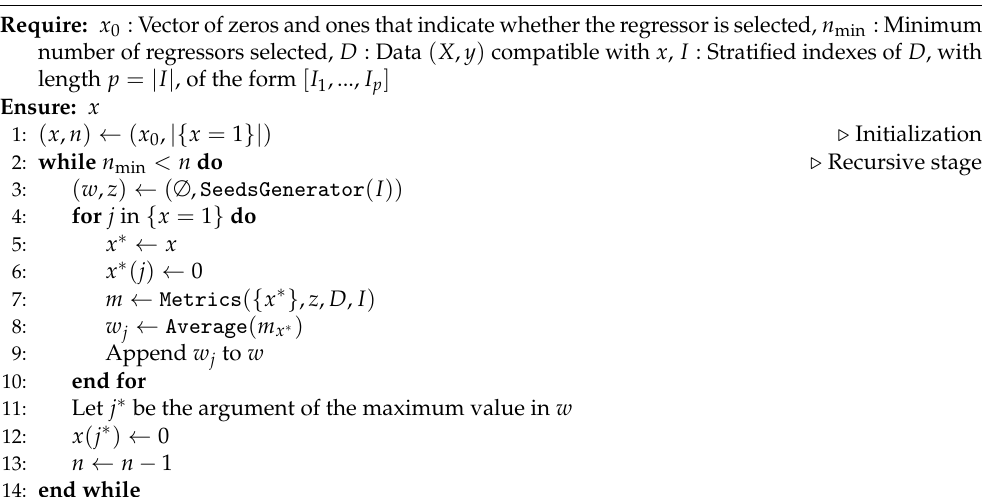
Algorithm A2 Reduction algorithm to feature